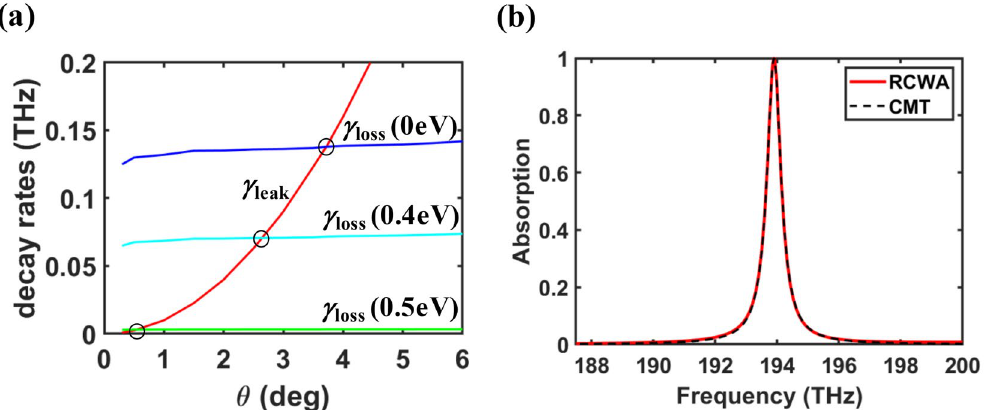
Figure 5. (a) Leakage and loss rates as a function of θ for different Fermi-levels of E f = 0, 0.4, and 0.5 eV, which are obtained by applying CMT model. Three open circles indicate the critical coupling condition for each E f . (b) Comparison of CMT and the RCWA calculation results for E f = 0 eV. All the remaining parameters are same as those of Fig.